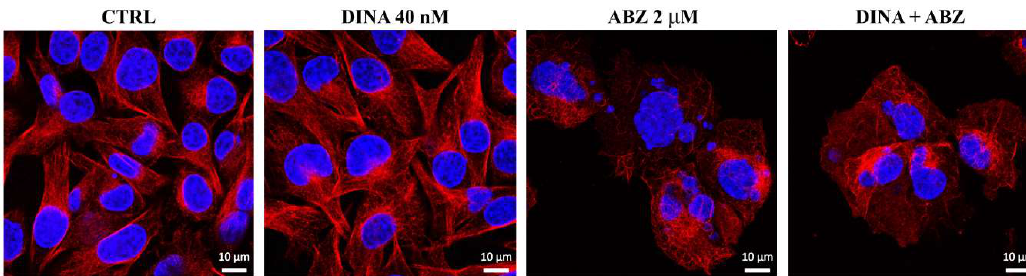
Figure 4. ABZ disrupts microtubules in A375 cells. Confocal laser scanning microscopy. Microtubules ( red ) stained by indirect immunofluorescence and nuclei (DAPI staining, blue ) after 24 h treatment with ABZ (2 μM), DINA (40 nM), and a combination of both. The regular network of microtubules in control and DINA-treated cells. Thinned, disappearing, and irregular microtubules and multiple nuclei were apparent in cells treated with ABZ and the combination of ABZ with DINA. Bar = 10 μm. DINA (40 nM) alone did not change the distribution of cell cycle phases in A375 cells. ABZ (1 and 2 μM) and FBZ (1 and 2 μM) and their combinations with DINA caused cell cycle arrest at the G2/M phase. The percentage of cells in the G2/M phase was lower in samples treated with combinations of DINA and benzimidazoles when compared to the treatments with benzimidazoles alone (Figure 5). This might be caused by the ability of DINA to interfere with the activity of multiple CDKs and stop the cell cycle in any phase.